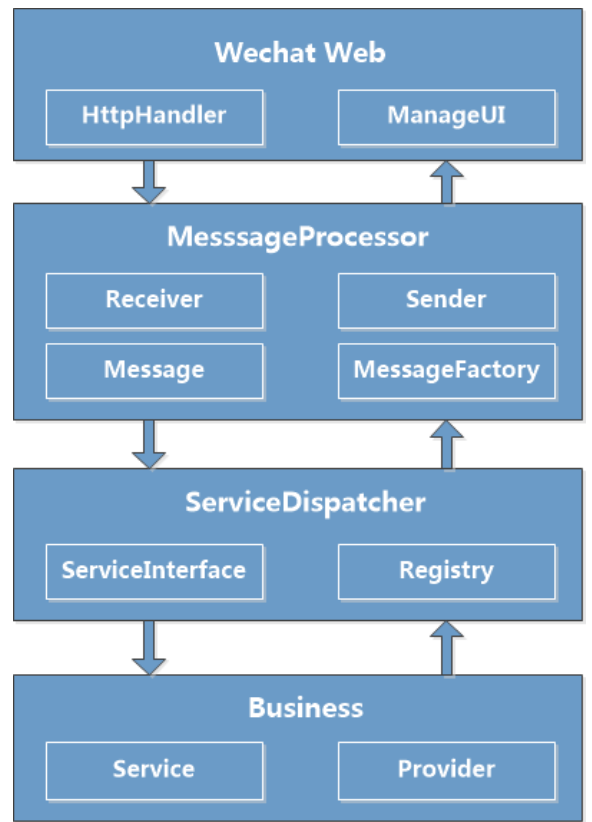
Figure 4. WeChat Mobile Service Framework